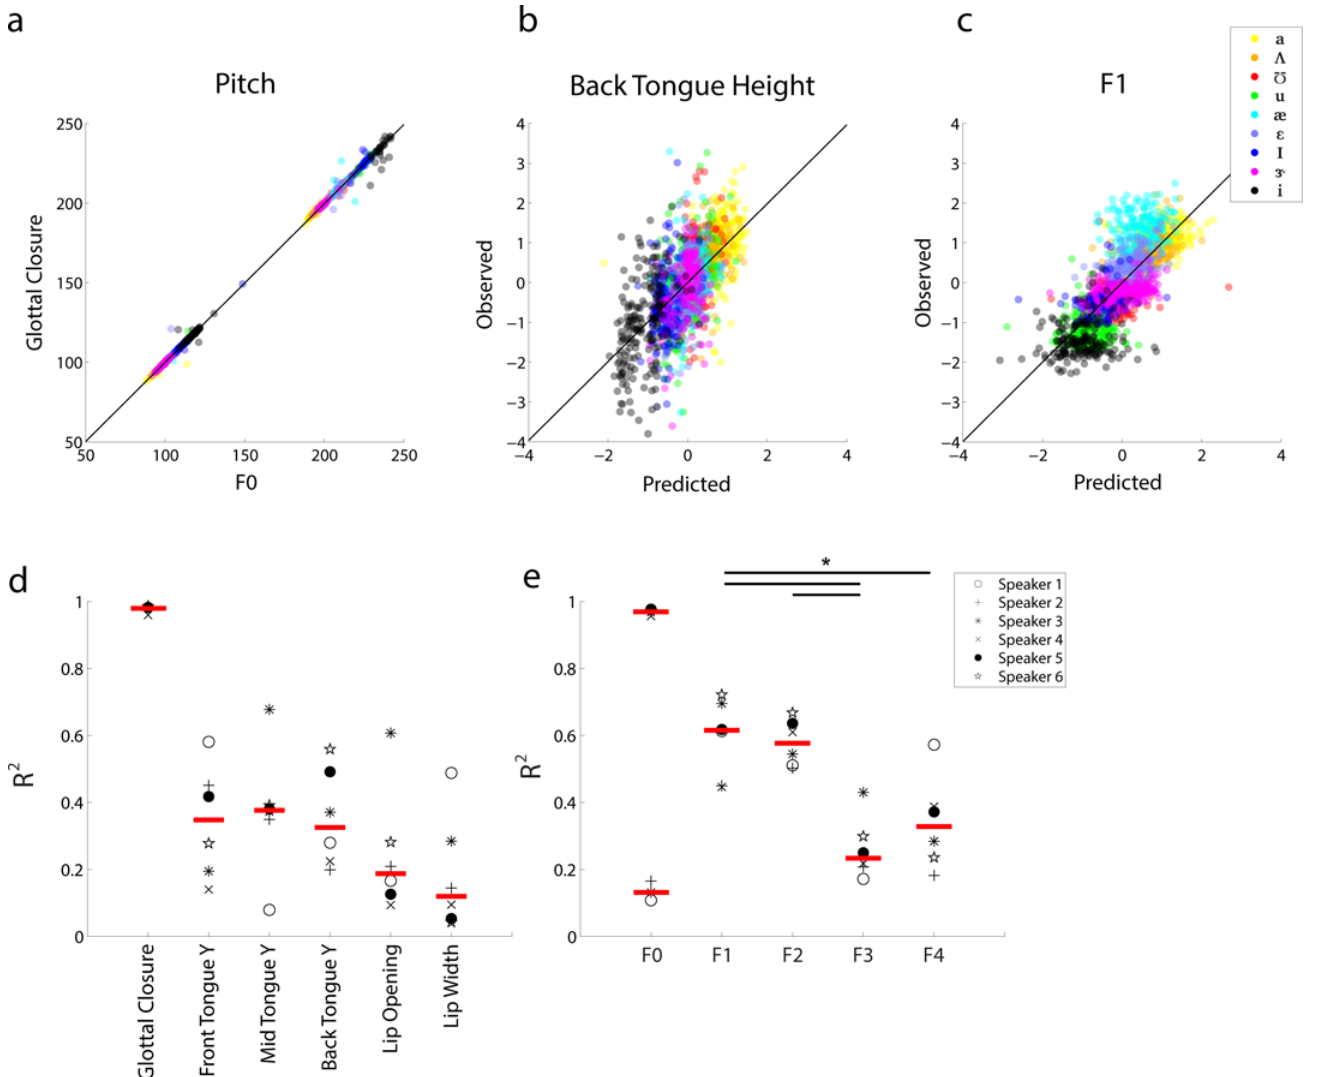
Fig 5. Continuous linear relationship between vowel acoustics and articulator position. a) Scatter plot of pitch values (F 0 ) vs. frequency of glottal closures from 3 subjects (2 males, 1 female). Color corresponds to vowel identity. b) Linear prediction of (z-scored) back tongue height from all acoustic features vs. the observed values for all nine vowels and six speakers. c) Linear prediction of (z-scored) F 1 from all kinematic features vs. the observed values for all nine vowels and six speakers. d) Acoustic-to-articulator mappings. Amount of explained variance (R 2 ) for six kinematic features from all acoustic features for each subject. Subjects are identified by symbol. e) Articulator-to-acoustic mappings. Amount of explained variance (R 2 ) for five acoustic features from all kinematic features for each